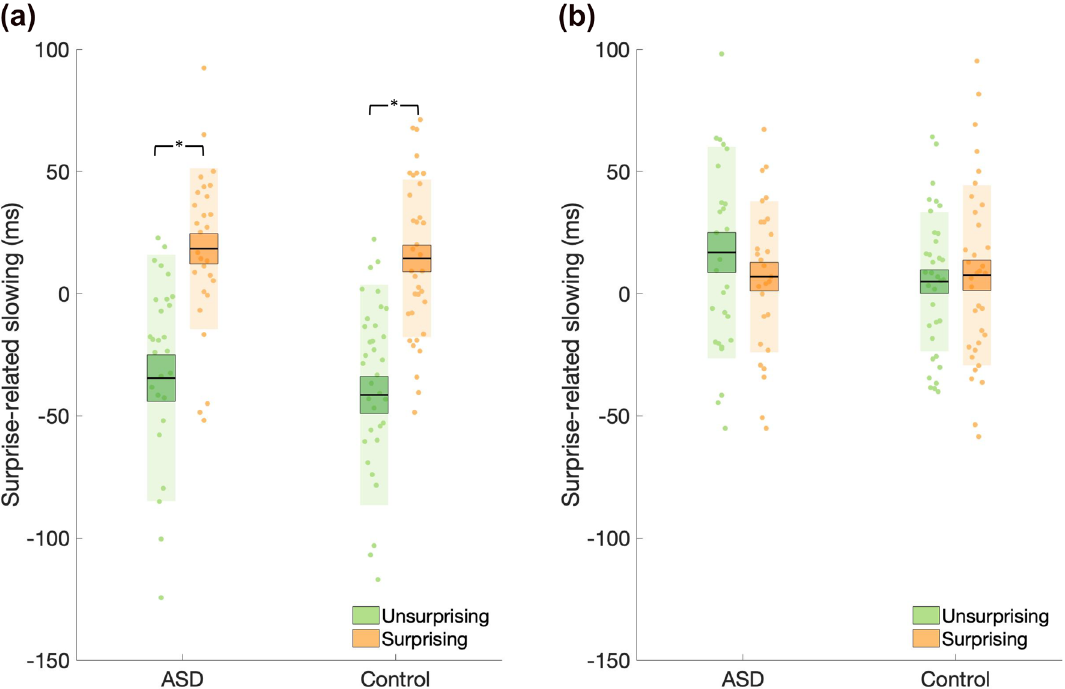
Figure 4. Surprise-related slowing ( a ) Easy-predictable condition . Data represent the difference between the mean reaction time (RT) for the unpredictable conditions and RT for surprising (orange) and unsurprising (green) trials. RT was significantly greater for surprising compared to unsurprising trials. ( b ) Difficult- predictable condition. There was no difference in RT between surprising and unsurprising trials in the difficult condition. No differences between the ASD and control group were observed in either condition. Data points indicate individual participants. The mean is the thick black horizontal line and 1 standard error of the mean (SEM) is represented by the shaded box around the mean. Standard deviation (SD) is the shaded